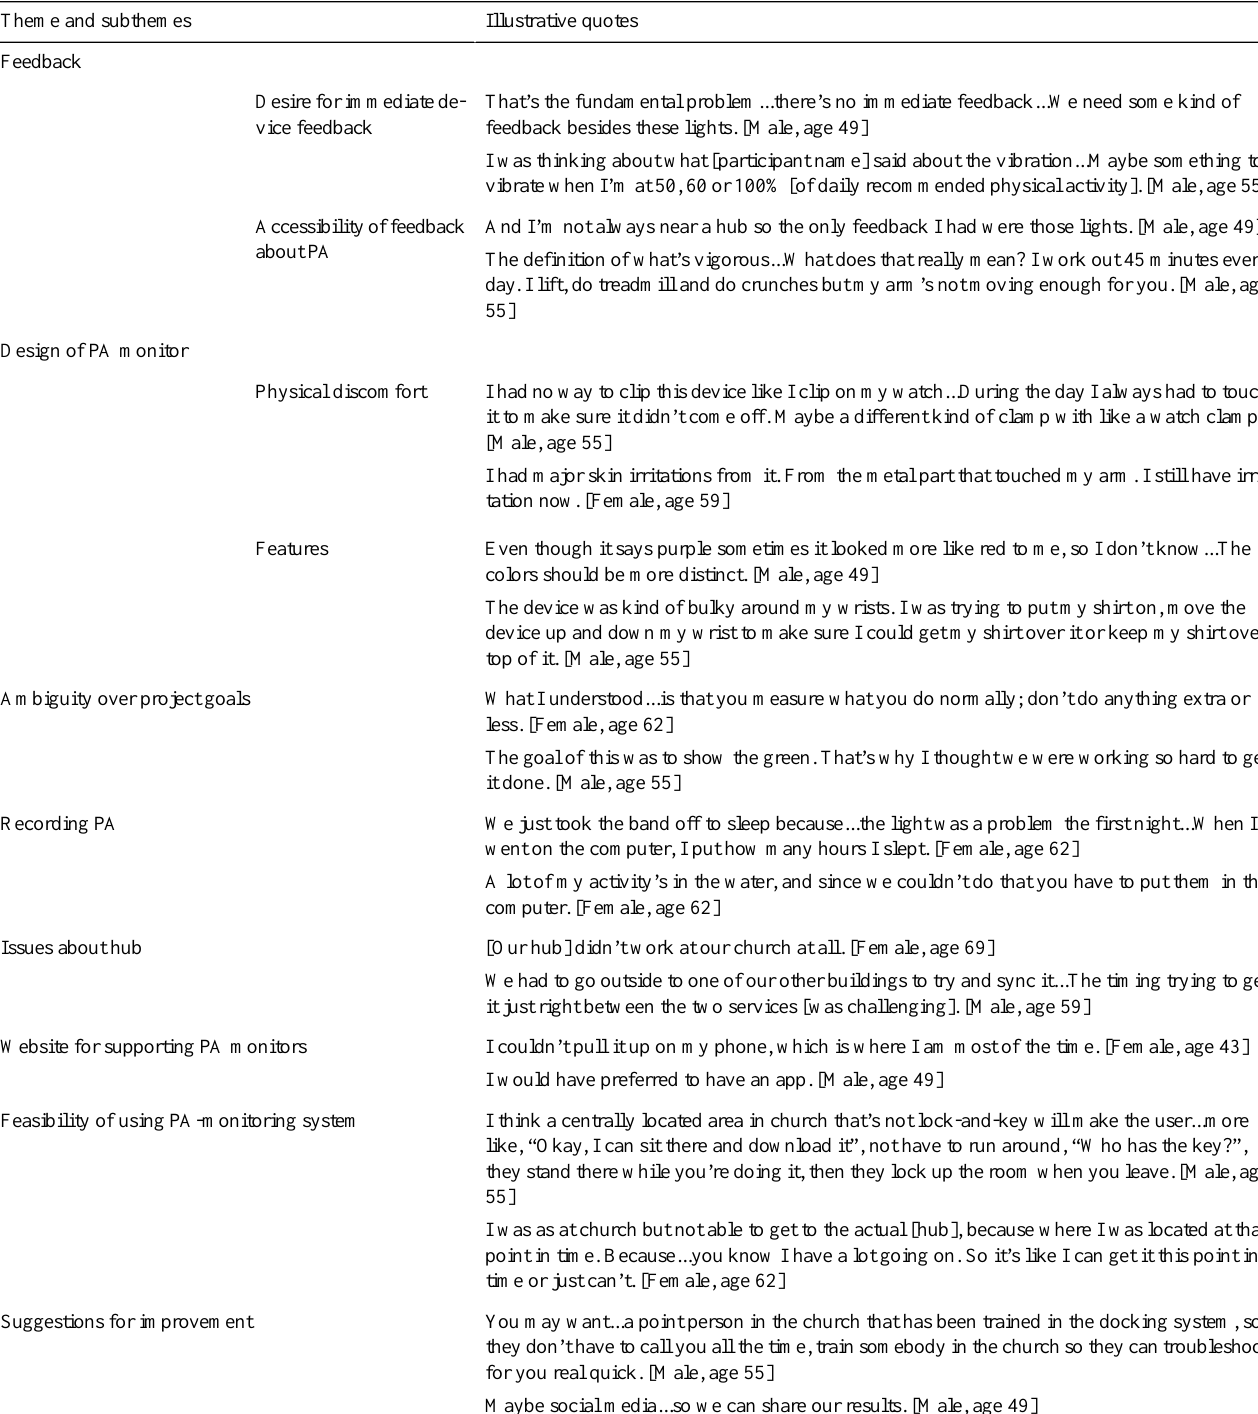
Table 2. Focus group themes, subthemes, and quotes - CV Health and Needs Assessment Qualitative Study, 2014.